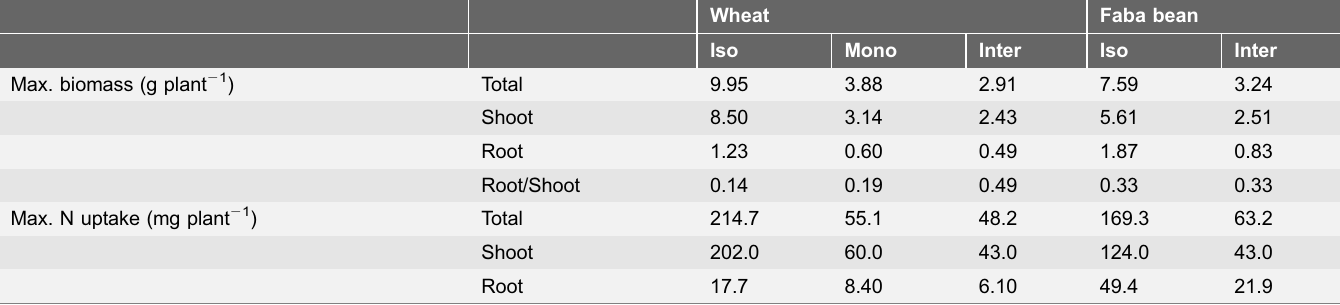
Table 1. The maximum biomass and nitrogen (N) uptake of wheat and faba bean estimated by a logistic model (Eqn 1).